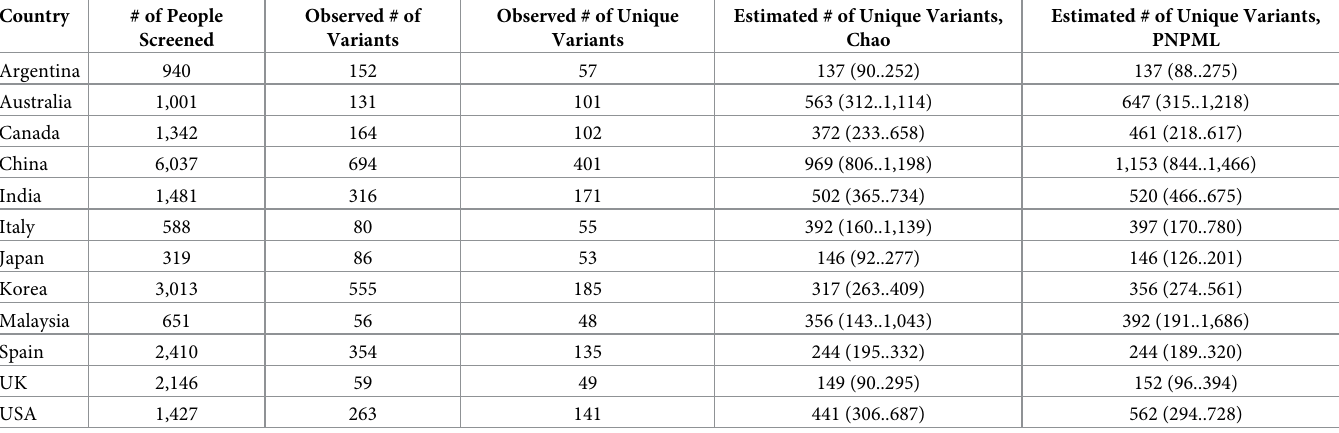
Table 2. Estimates for the total number of unique pathogenic BRCA1/2 variants in different countries using Chao and PNPML estimators. Country # of People